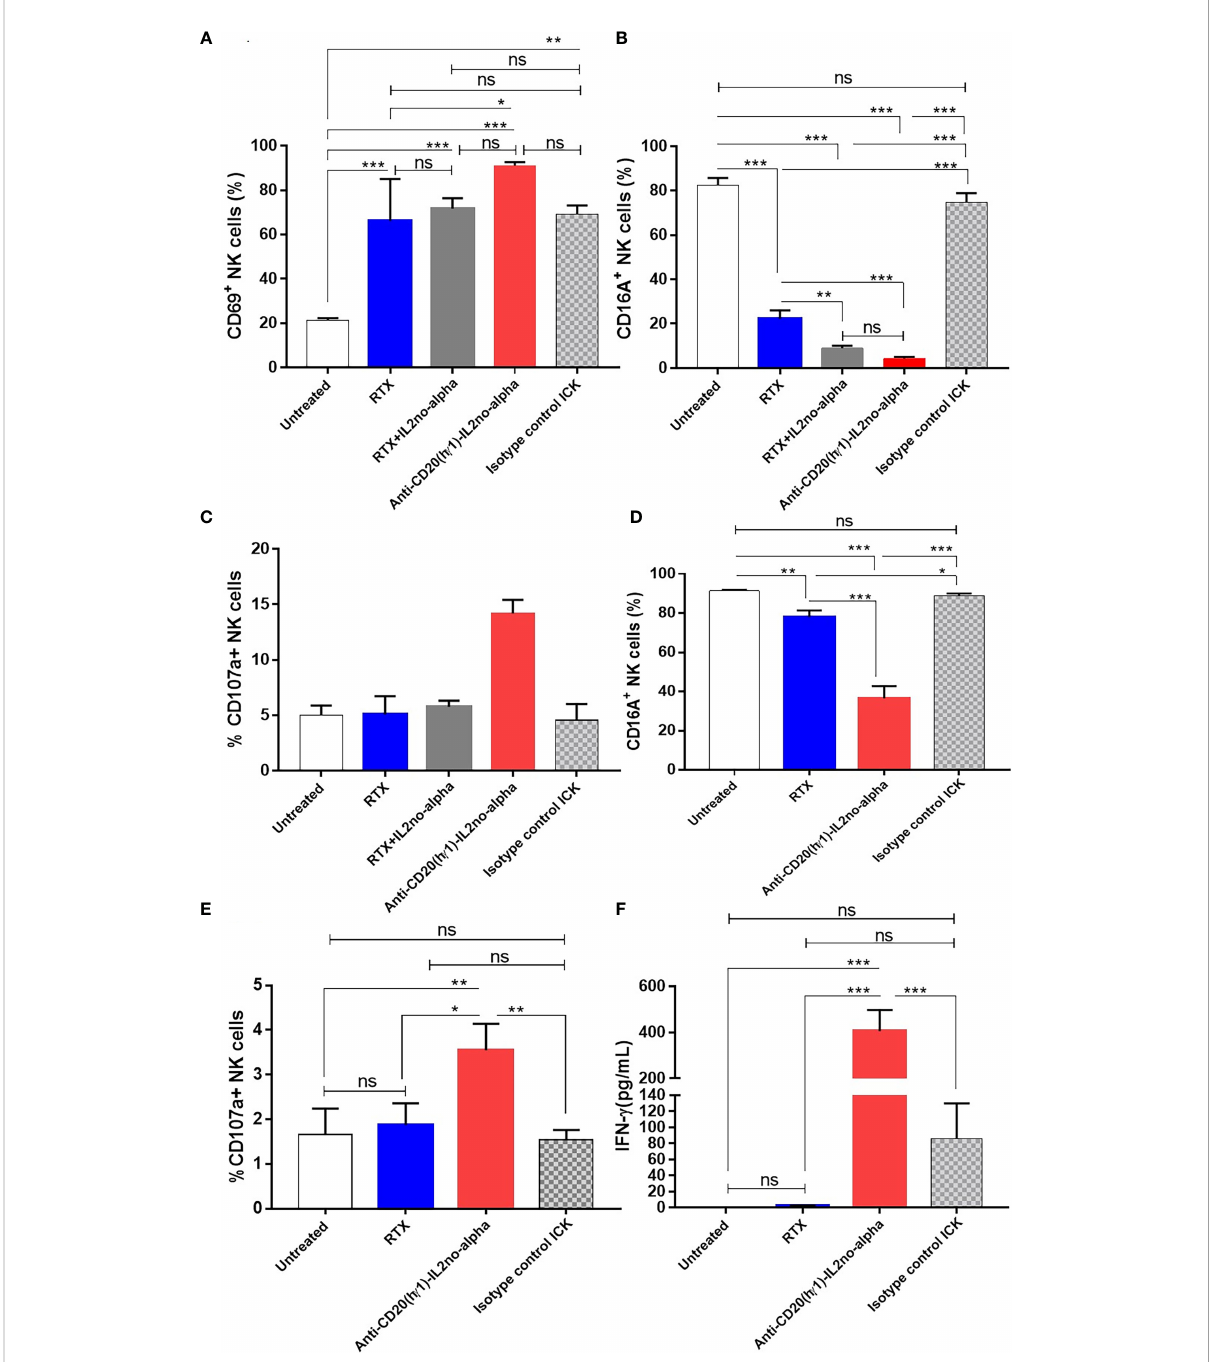
FIGURE 5 Anti-huCD20(h g 1)-IL2no-alpha ICK induces NK-cell activation and cytotoxic function. (A – C) , freshly human PBMC (used as a source of NK cells) and Ramos cells were cocultured at a 10:1 ratio in presence of 6nM ICKs (Anti-huCD20(h g 1)-IL2no-alpha or isotype control ICK), or RTX (6nM), or RTX (6nM) + mutein IL-2no-alpha (equimolar amount of cytokine). Flow cytometry analyses of NK cell (CD3-CD56+) activation membrane markers (A) , CD69, (B) CD16A, and degranulation marker (C) CD107a are shown (D – F) , freshly human PBMC and PBMC of refractory low- grade B-cell lymphoma cells were cocultured at a 10:1 ratio for 21 h at 37°C. Flow cytometry analyses of NK cell activation markers (D) , CD16A and (E) degranulation marker CD107a are shown. Percentage is referred to as the proportion of cells within the whole NK cell population expressing CD69, CD16A or CD107a markers. (F) IFN- g levels in supernatants of cell cultures measured by ELISA. Data represent the mean ± SEM. (Kruskal-Wallis, Dunn ’ s post hoc test, *P < 0.05; **P <0.01; ***P < 0.001; ns, not signi fi